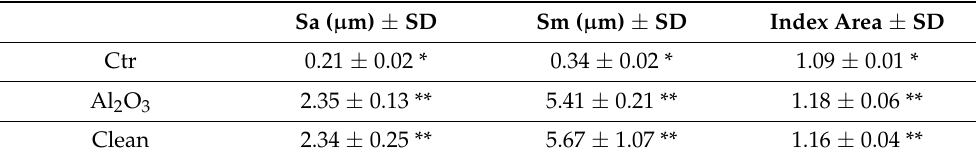
Table 1. Roughness of the titanium surface. Statistical differences for each column are indicated by single asterisk and double asterisk symbols ( p < 0.05).